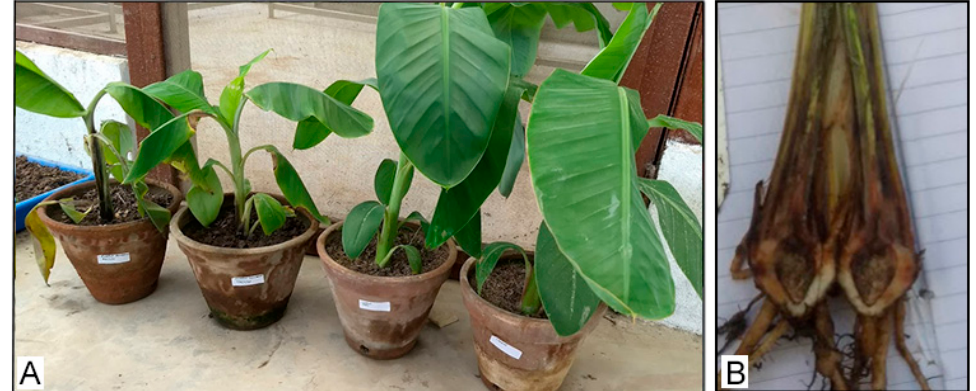
Figure 3. Pathogenicity test on the Malbhog (AAB) variety at the National Plant Pathology Research Center, NARC, Khumaltar, Nepal. ( A ) Inoculated (left two plants) and non-inoculated as control (right two plants); ( B ) rhizome discoloration caused by Foc isolates after inoculation.